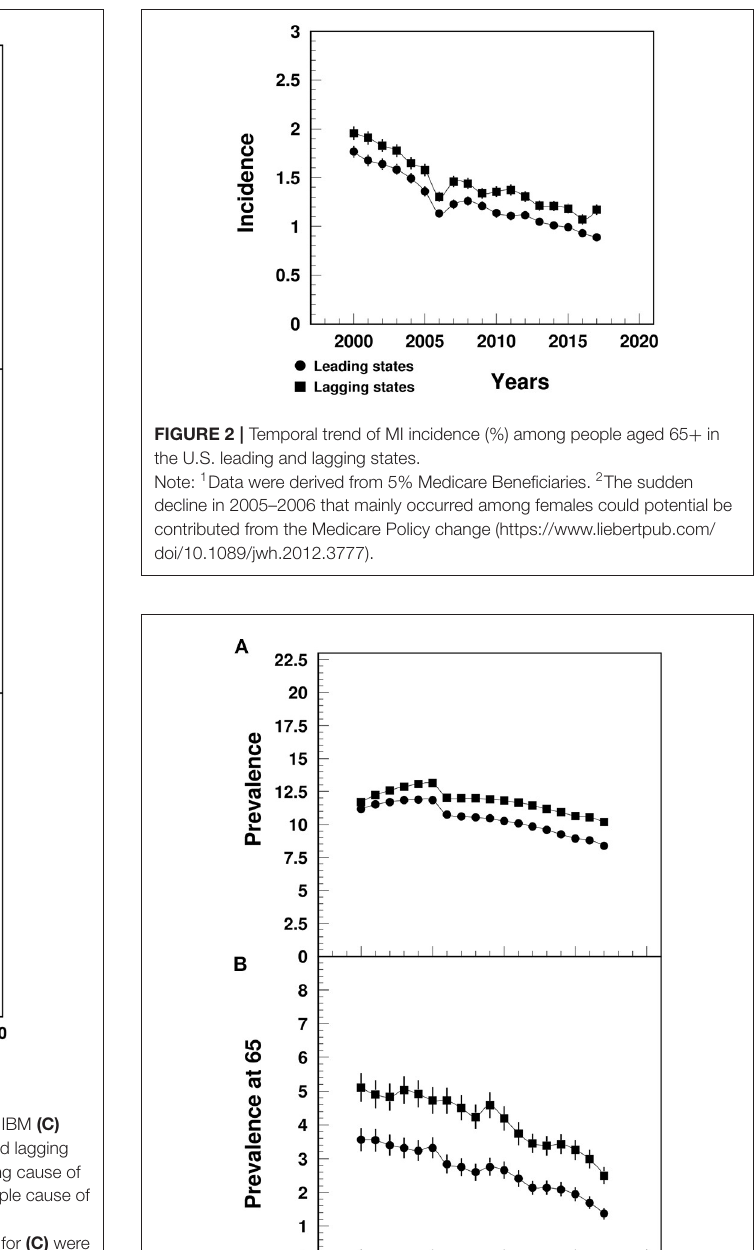
for total sample, 1.18 (1.16, 1.20) for males, 1.17 (1.15, 1.19) for females, 1.19 (1.18, 1.21) for White, but not for Blacks